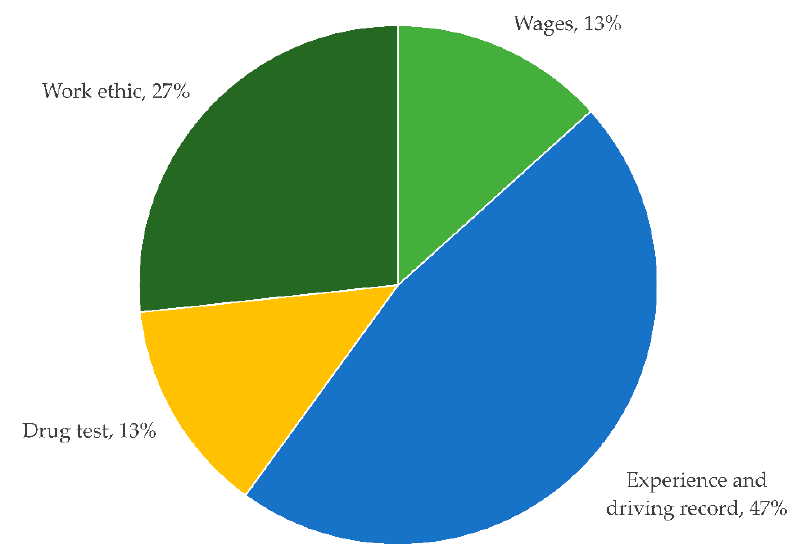
Figure 1. Barriers to recruiting new log truck drivers identified by interview participants. The percentages listed are for the first challenge identified by respondents.